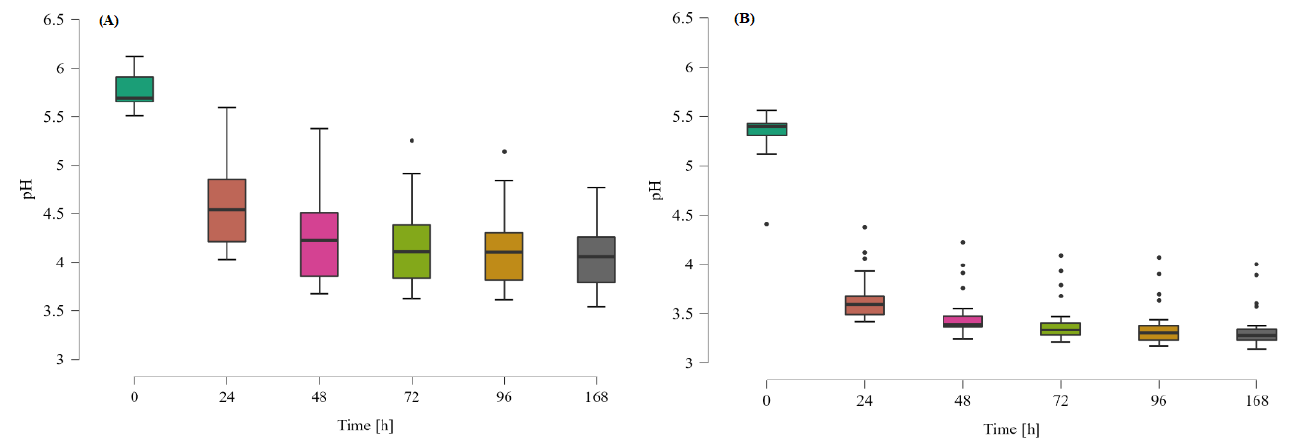
Figure 4. Boxplots presenting changes in the pH in the co-cultures grown on the medium enriched with the resistant dextrin ( A ) and with glucose as the control ( B ). The mean results from three repetitions for 30 samples. All results ( A ) are significantly different from results ( B ), which was tested by one-way ANOVA with post-hoc Tukey’s test ( p < 0.05). Dots represent the outlier values.